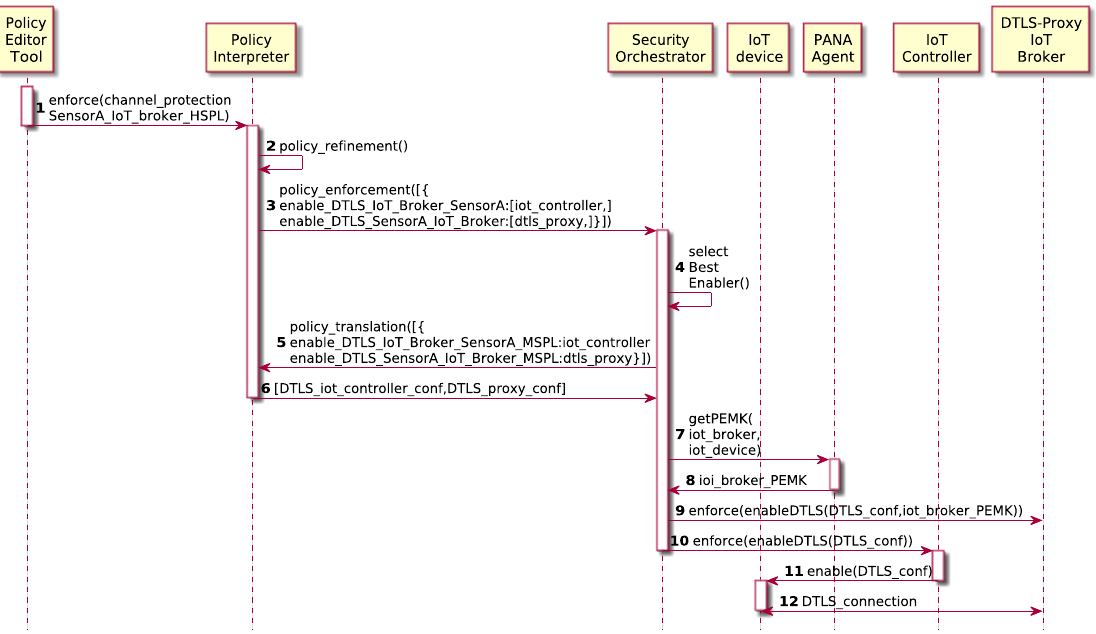
Figure 6. Softwarized and centralized Channel Protection